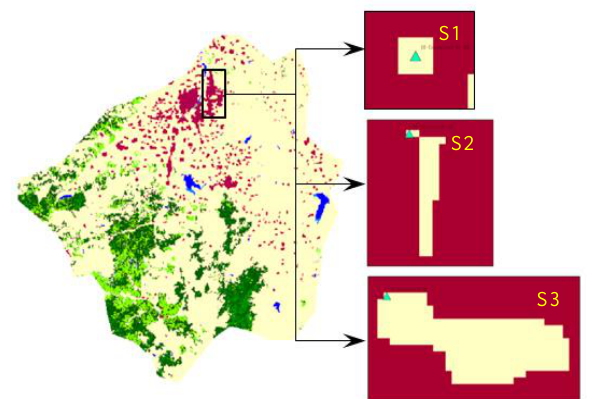
Figure 8. Inconsistency detection for artificial surface contain cultivated land in study area for year 2010.